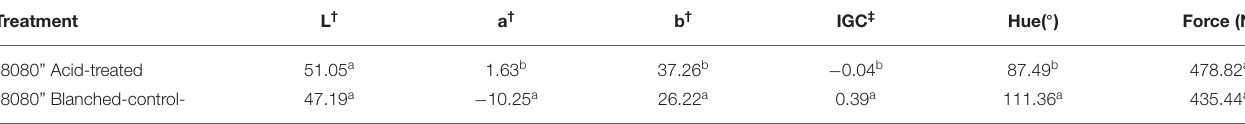
TABLE 1 | Color and texture of edamame cultivar “8080” when blanched and processed in acidic brine (Acid-treated) vs. blanched without further processing (Control). Treatment L † a † b † IGC ‡ Hue( ◦ ) Force (N) “8080” Acid-treated